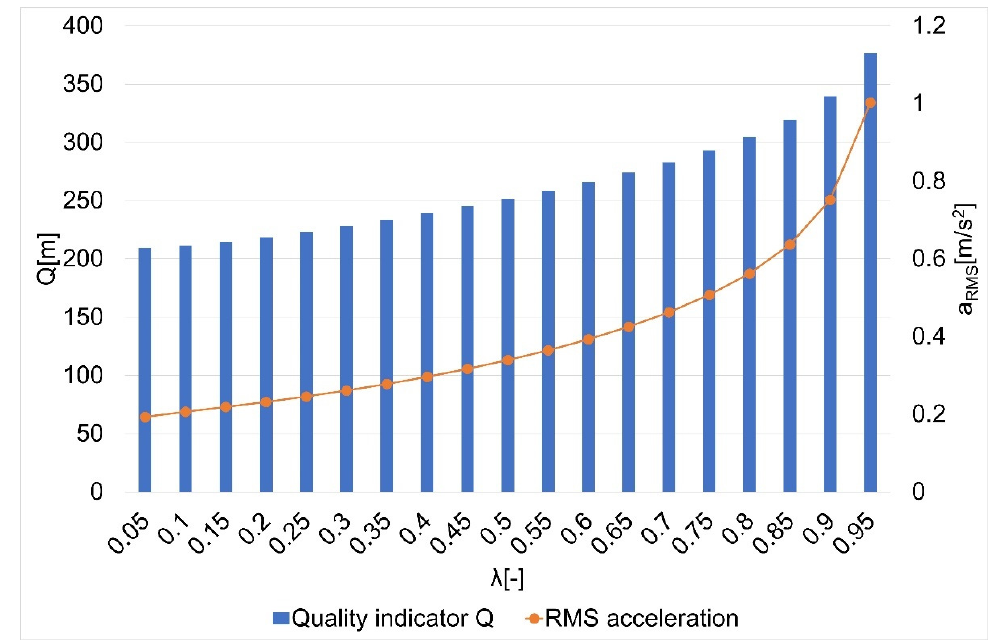
Figure 7. The values of the quality indicator Q and the mean square value of acceleration a RMS for the smoothing parameters in the case of path no. 3 [6].